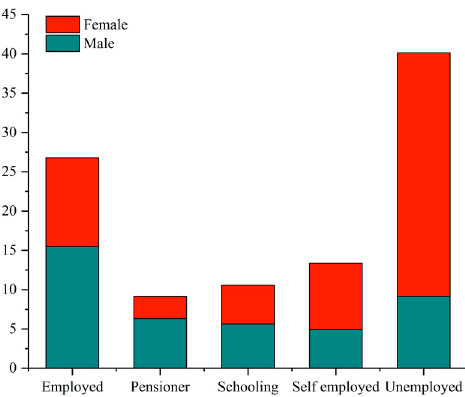
Figure 4. Employment levels according to gender levels in the Nzhelele and Levuvhu river catchments.